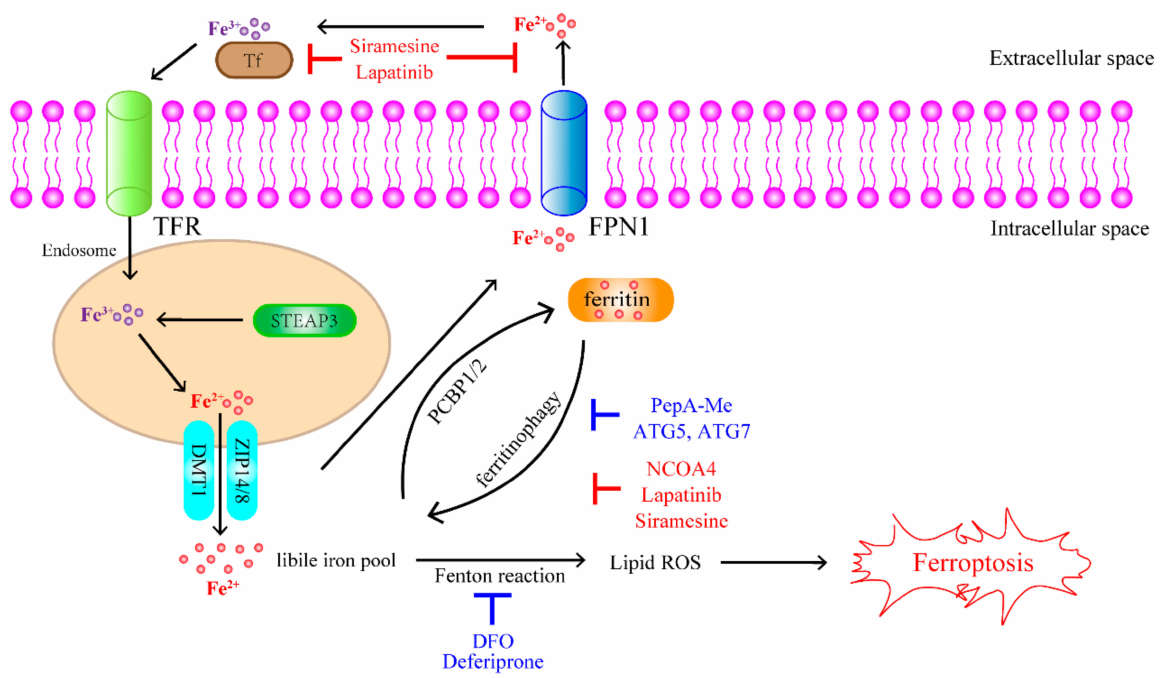
Figure 2. The mechanisms of iron-mediated ferroptosis. Fe 3+ is imported into the cell via the TfR1 membrane protein and reduced to Fe 2+ in endosome. DMT1 or ZIP14/8 transports Fe 2+ from the endosome into the LIP. The Fe 2+ in the LIP then undergoes any of the following three steps: (i) Fe 2+ is oxidized by Fpn1 and is exported out of the cell; (ii) the excess Fe 2+ is stored in ferritin; (iii) Fe 2+ is utilized in the Fenton reaction, causing the accumulation of ROS, thereby inducing